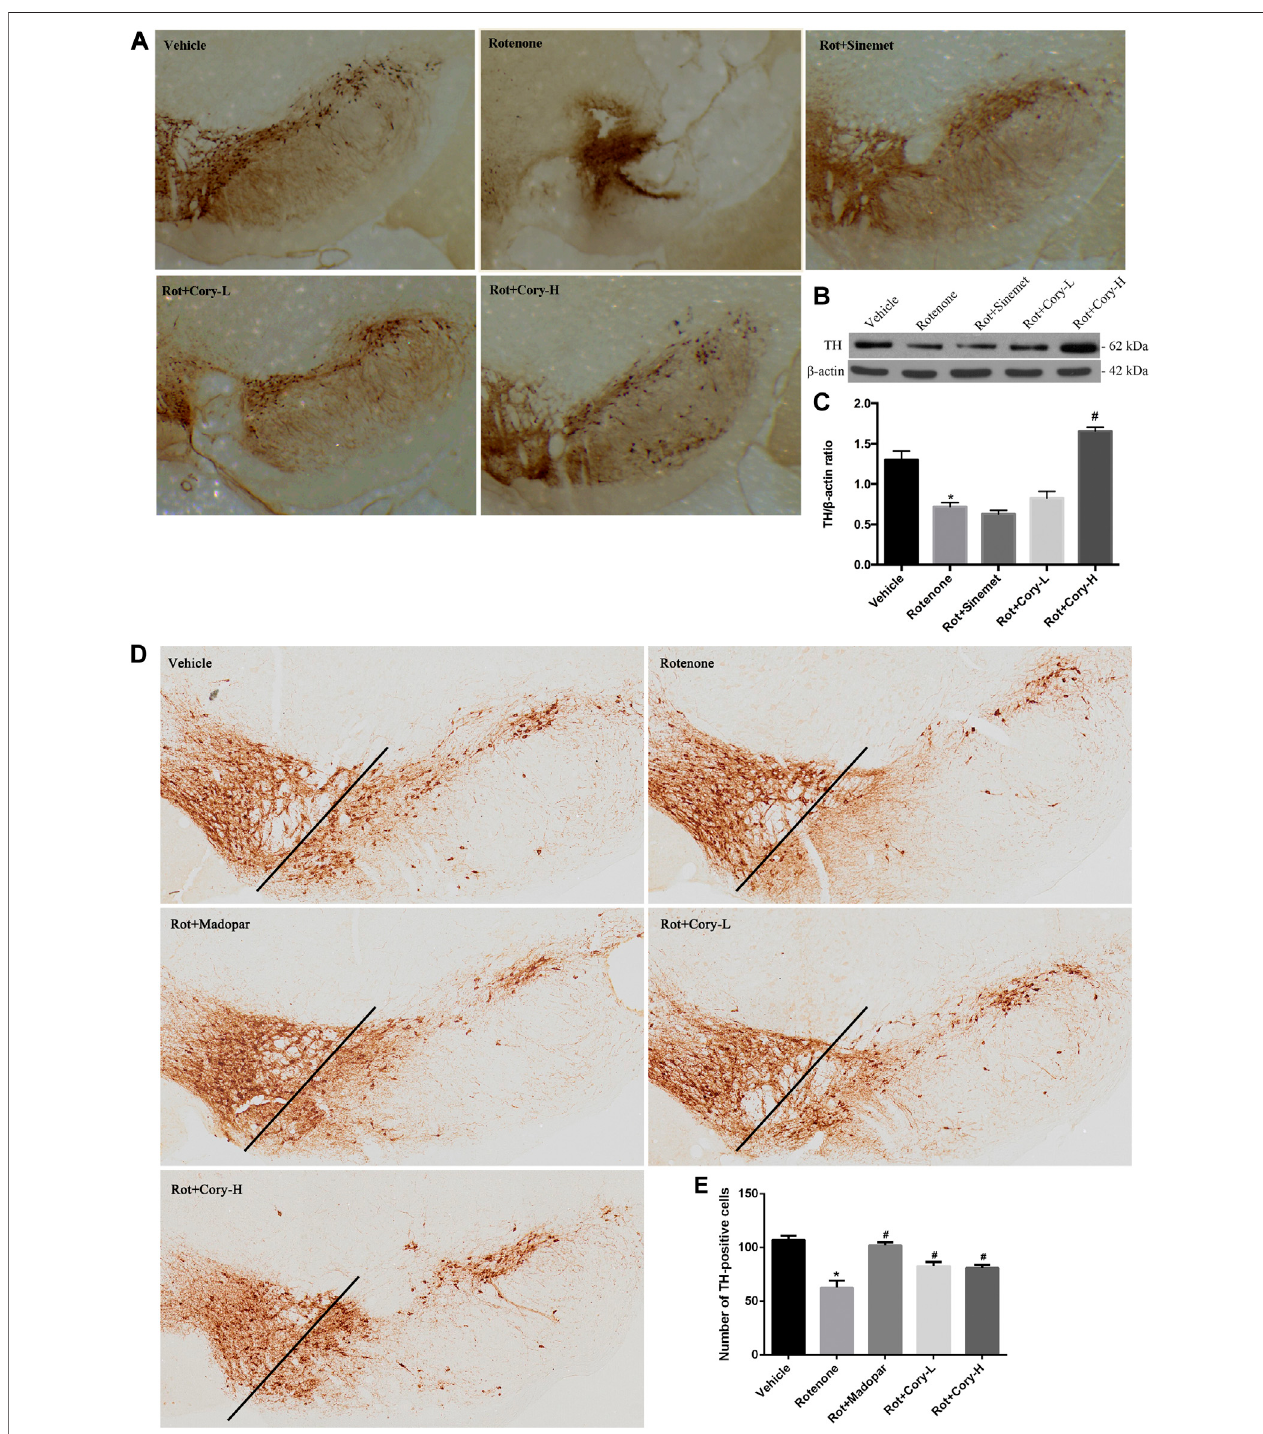
FIGURE 2 | Cory prevents the loss of tyrosine hydroxylase – positive neurons in the SNpc. (A – C) Tests in the rotenone-induced rat model of PD, and (D – E) tests in therotenone-inducedmicemodelofPD.ImmunostainingresultsrevealthatCorypreventsthelossoftyrosinehydroxylase – positiveneuronsintheSNpcofthePDrat (A) andmice (D – E) models. (B,C) Coryincreasestheleveloftyrosinehydroxylase.TherightsideofSNpcwasisolatedfromthebraintissueofthePDratmodel.Afterprotein extraction, samples were subjected to Western blotting assay. Dosage of Cory in the rotenone-induced rat model of PD: Cory-L: 2.5 mg/kg, Cory-H: 5 mg/kg. DosageofCoryintherotenone-inducedmicemodelofPD:Cory-L:5 mg/kg,Cory-H:10 mg/kg.Datawerepresentedasmean ± SEM.(* p < 0.05comparedwithSham or Vehicle group, # p < 0.05 compared with the Rotenone group, n ≥ 6; one-way ANOVA with Newman – Keuls ’ multiple test.)